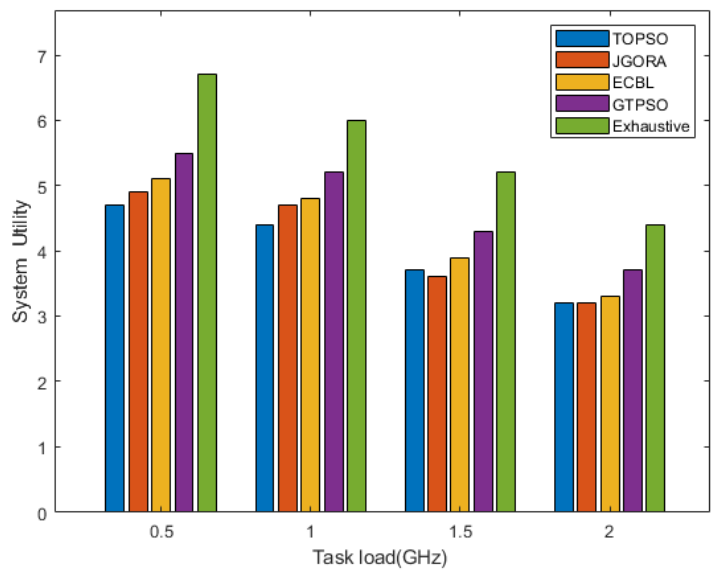
Figure 2. Comparison of system utility. Table 2. Runtime of schemes (ms).